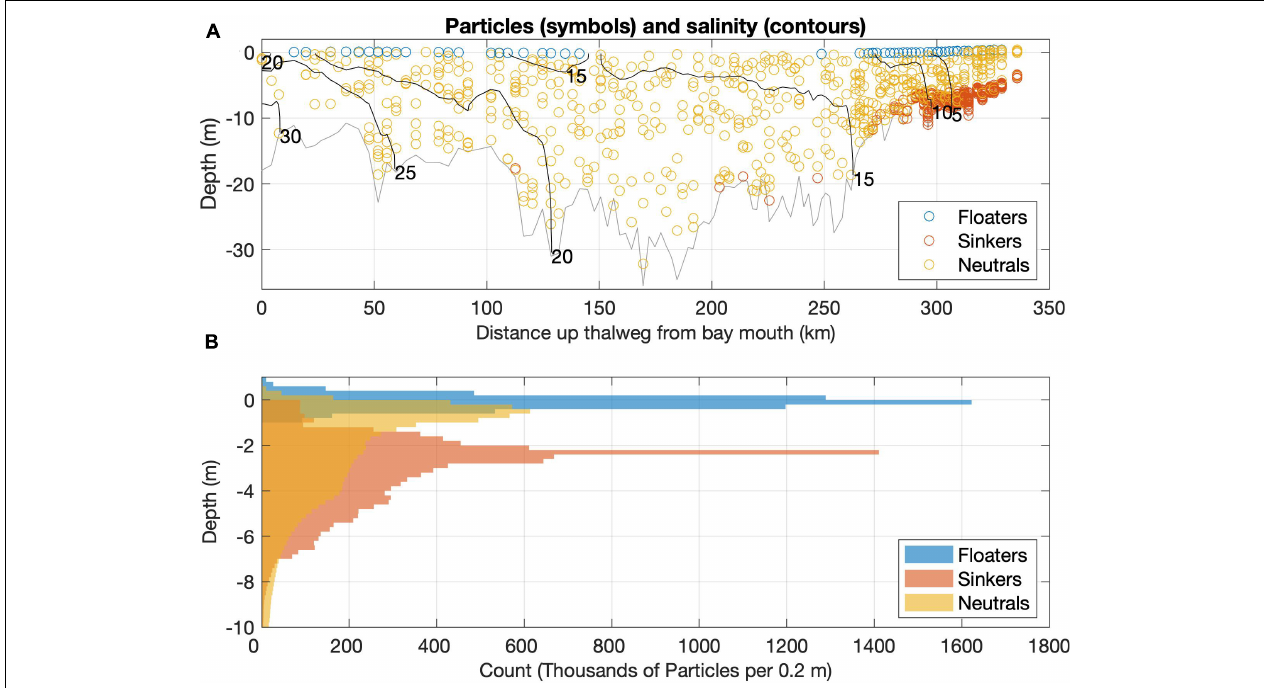
FIGURE 7 | (A) Particle locations and salinity within a transect one grid point wide along the thalweg on the final day (366th day, January 1, 2011) of the composite simulation. (B) Particle abundance integrated over time and horizontal extent vs. depth over the course of the 1-year composite simulation for floaters, sinkers, and neutral-density particles. Each point on the plot is the cumulative sum over all days for particles within a depth interval of 0.2